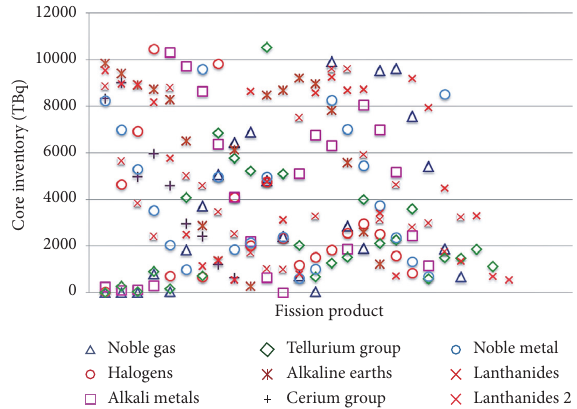
Figure 5: Reactor core radionuclide inventory classified into eight